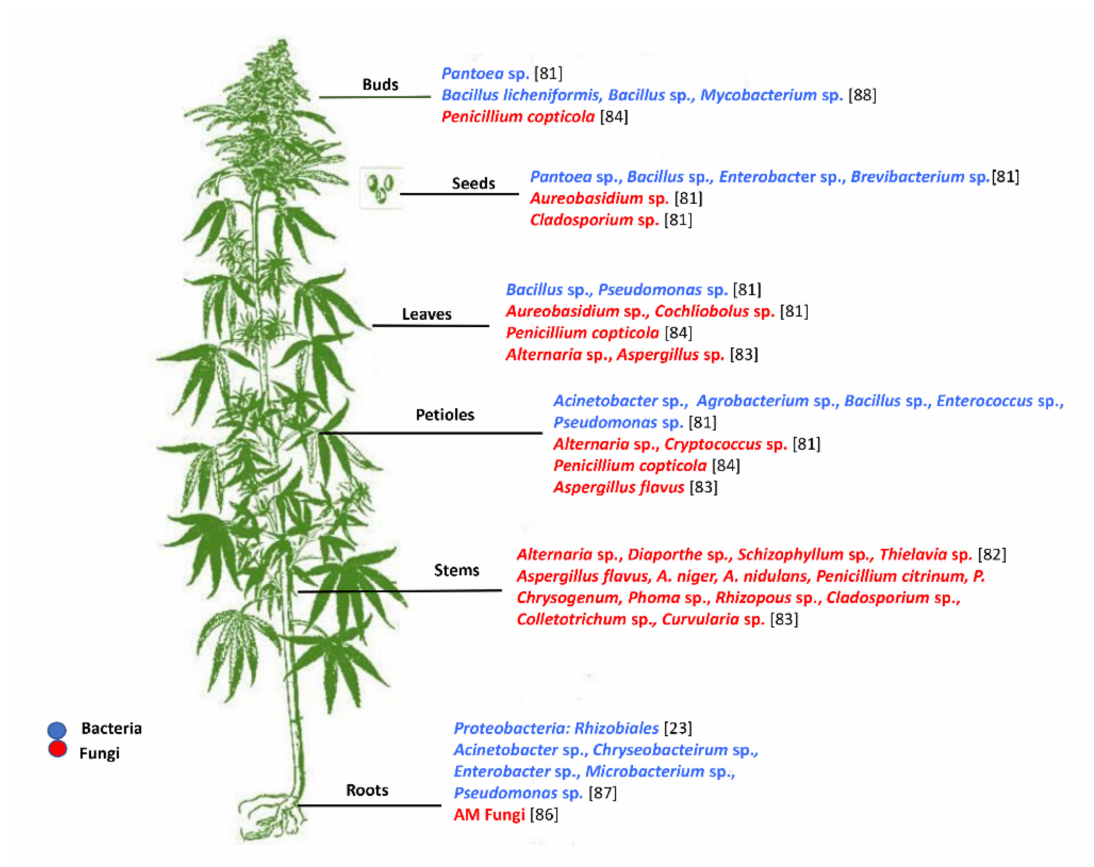
Figure 1. The most common endophytes harboured in di ff erent tissues of Cannabis sativa plants obtained from di ff erent geographical